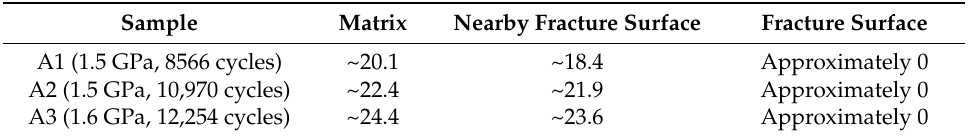
Figure 8. SEM fractograph of microstructure near main crack ( MC ) and secondary crack ( SC ) fracture surfaces of the A2 sample following fatigue break at maximum stress of 1.3 GPa and 49,168 cycles.